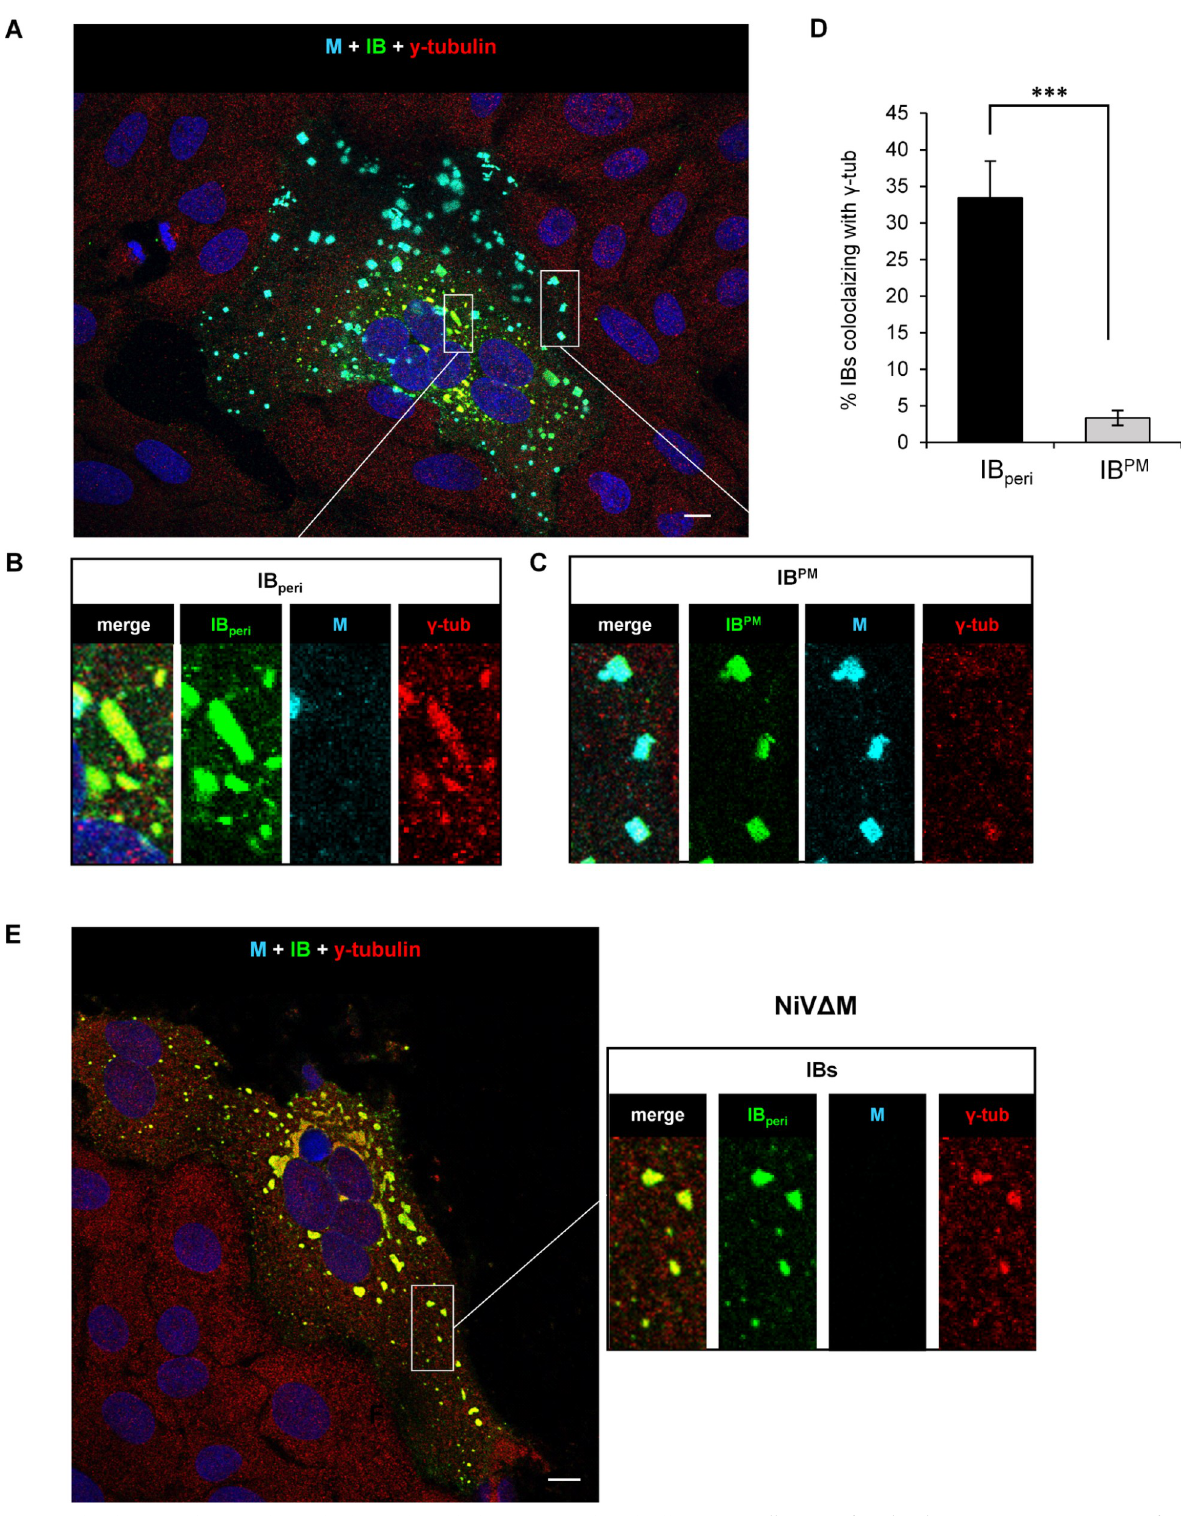
Fig 8. Colocalization of NiV inclusion bodies with y-tubulin in virus-infected cells. Vero76 cells were infected with NiV or NiV Δ M at a MOI of 0.05 or 0.01, respectively. At 18.5 h p.i. cells were fixed with 4% PFA for 48 h and permeabilized then with methanol/acetone. Cells were stained with an anti-N serum to visualize IBs (green) and with a Zenon-labeled anti-M peptide serum (cyan) to identify M-positive IB PM . For γ -tubulin detection,